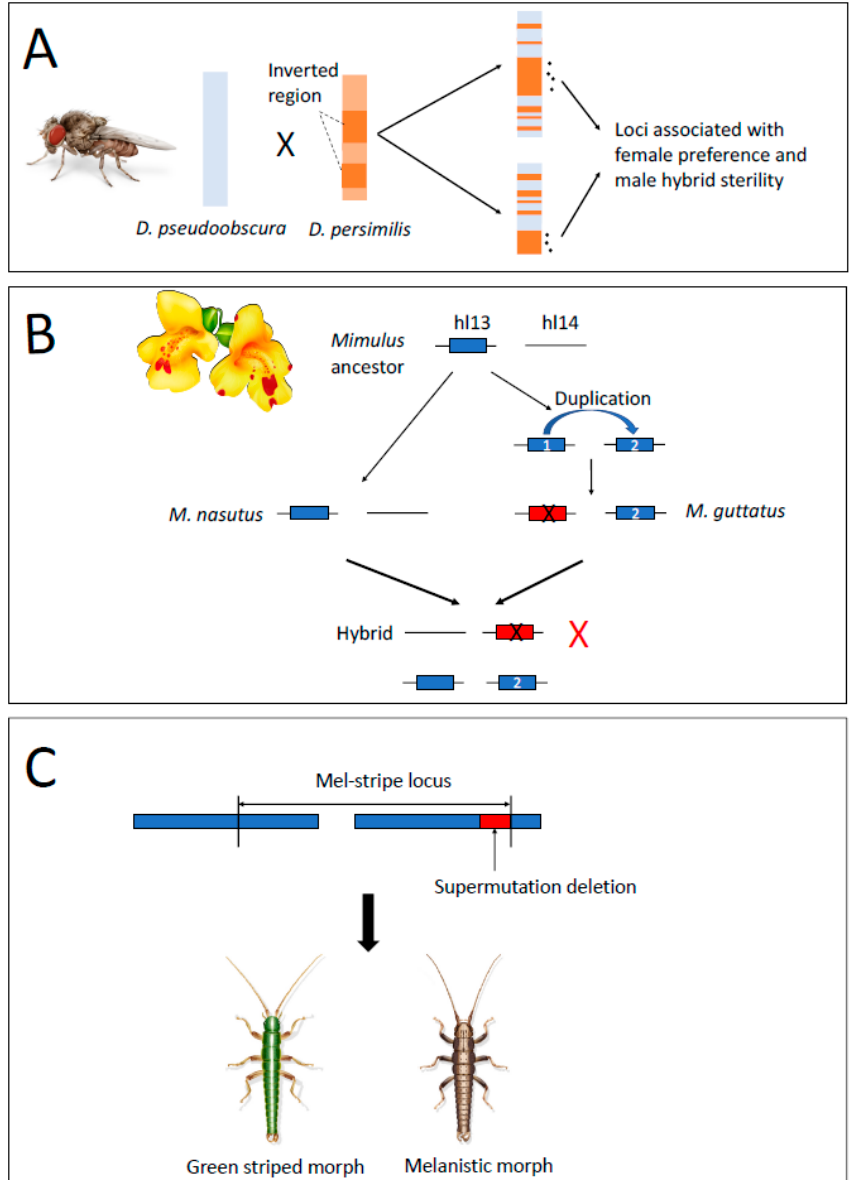
Figure 2. Example cases of structural variants involved in reproductive isolation. ( A ) Loci associated with female preference and male hybrid sterility located within an inversion in Drosophila pseudoob- scura [14]. Blue color represents genomic region from D. pseudoobscura , and orange color represents genomic region from D. persimilis . ( B ) Loss of function in duplicated genes lead to hybrid lethality between Mimulus guttatus and M. nasutus [57]. Black crosses indicate the loss of the gene function, while the red cross represents the reduced fitness of the hybrid individual. ( C ) Deletion and inversion act as large mutation leads to color morph variation among Timema species both increasing (melanic morph) and decreasing (green versus striped morphs) RI between hosts [30]. Drawings of Drosophila , Mimulus and Timema credit to Rosa Marin